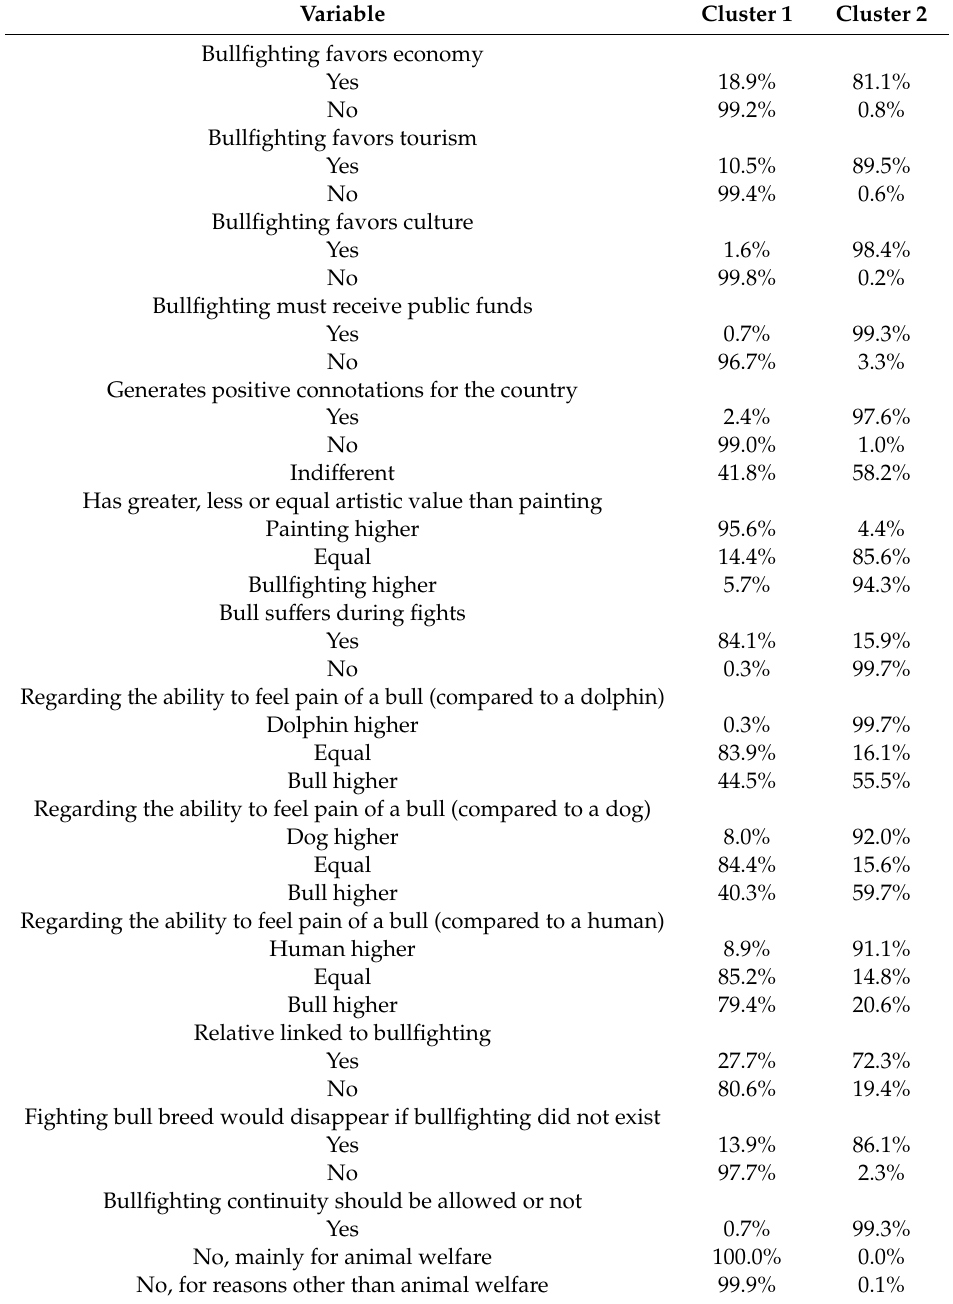
Table 5. Composition of opinions regarding bullfighting in Portugal as obtained by a two-step cluster